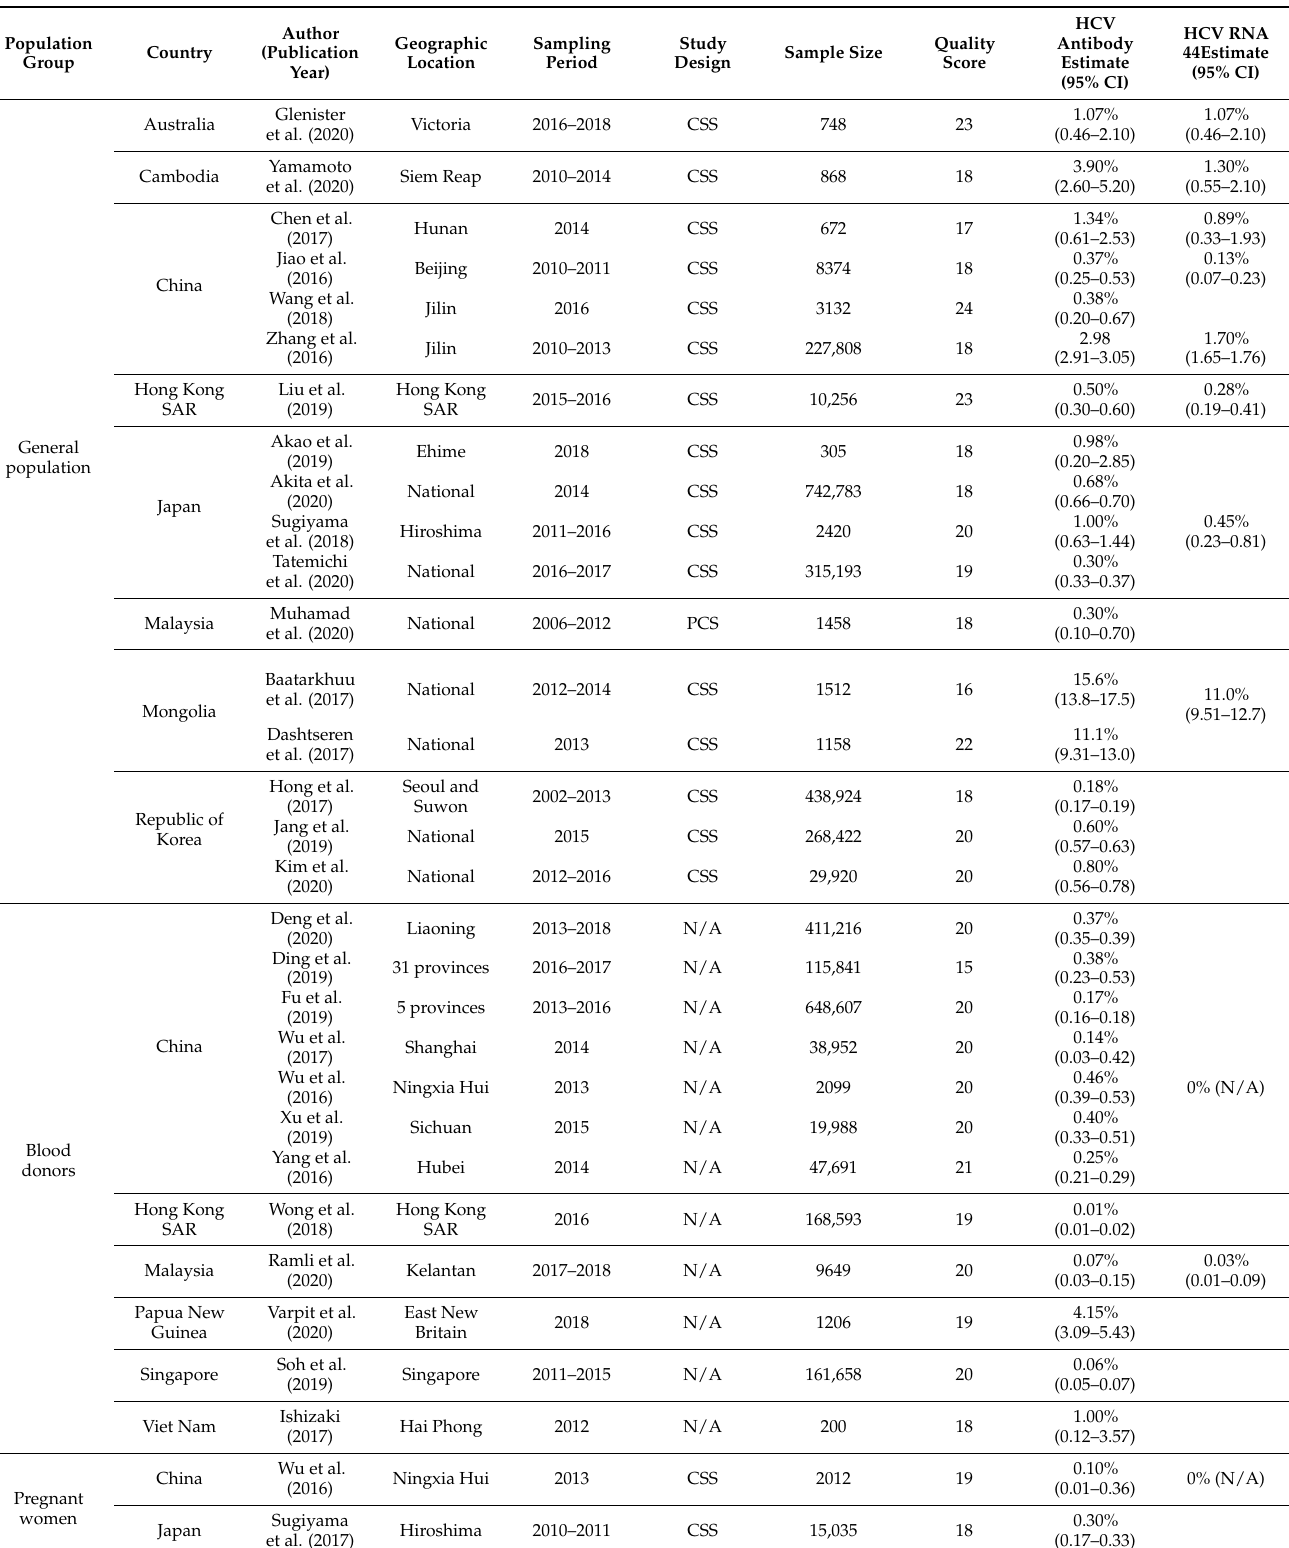
Table A2. Estimates for the prevalence of HCV antibodies (n = 31) and HCV RNA (n = 11) among the general